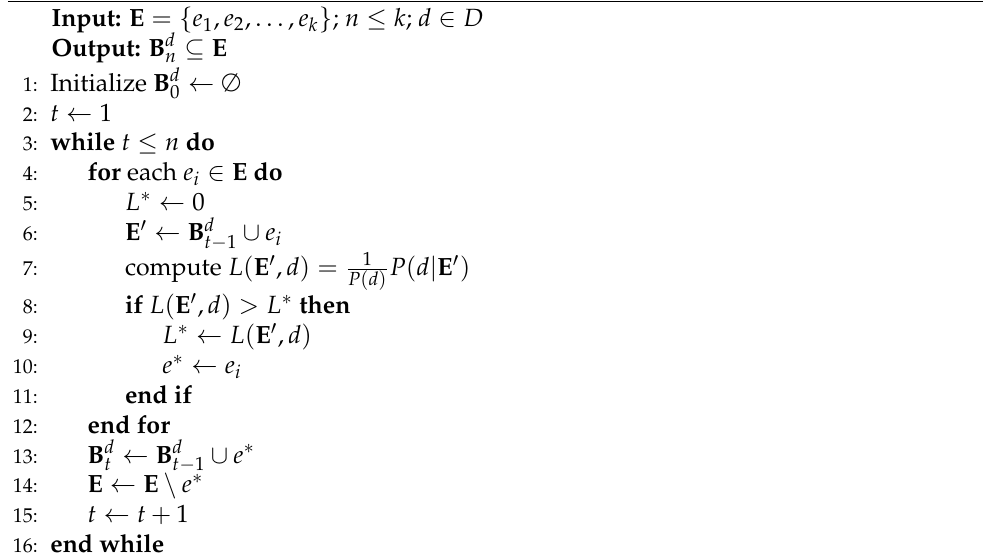
Algorithm 1 The BN-DSSApple explanation